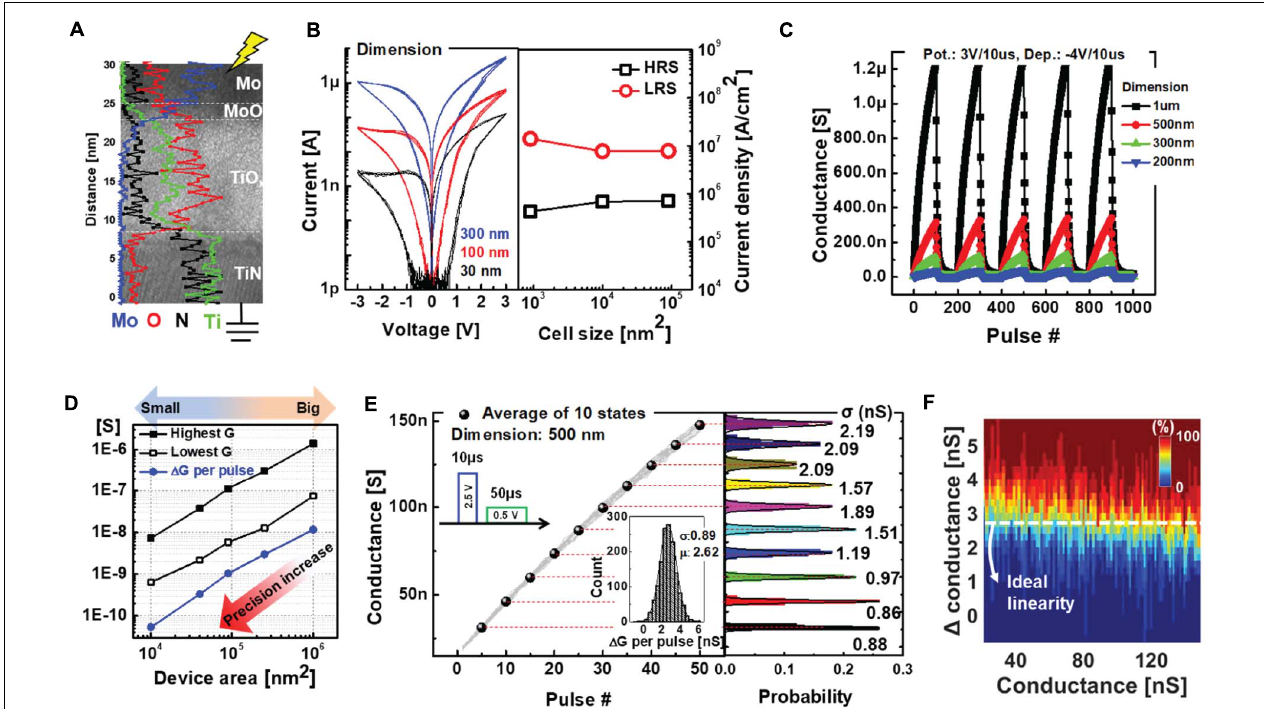
FIGURE 3 | (A) Transmission electron microscopy (TEM) image showing the cross section of the Mo/TiO x -based RRAM. EDS line profiles are indicated with different colors depending on the materials. (B) DC I-V curve and corresponding current density at 0.5 readout voltages of devices with different dimensions. (C) AC pulse responses of RRAMs with different dimensions. (D) Conductance scaling as a function of active device area. (E) Gradual and linear potentiation characteristics of the Mo/TiO x -based RRAM for 30 cycling operations. A pulse-train that consists of five –4 V/100 µ s pulses is used for strong depression process. (F) Heat map showing the cumulative probability to achieve a particular conductance change as a function of the total